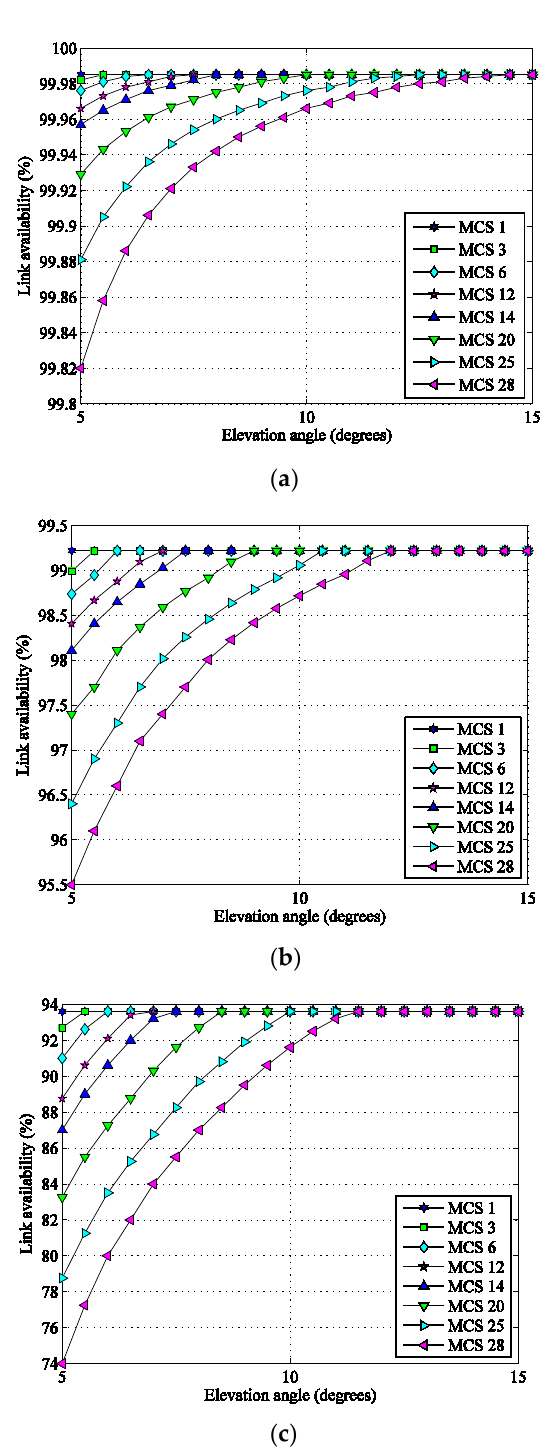
Figure 7. Link availability of each MCS at different elevation angles. ( a ) Kashgar G/S; ( b ) Beijing G/S; ( c ) Sanya G/S. G/S; ( c ) Sanya